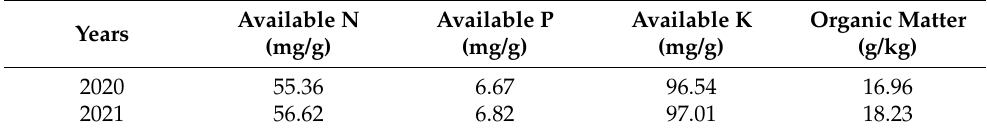
Table 1. Soil fertility before